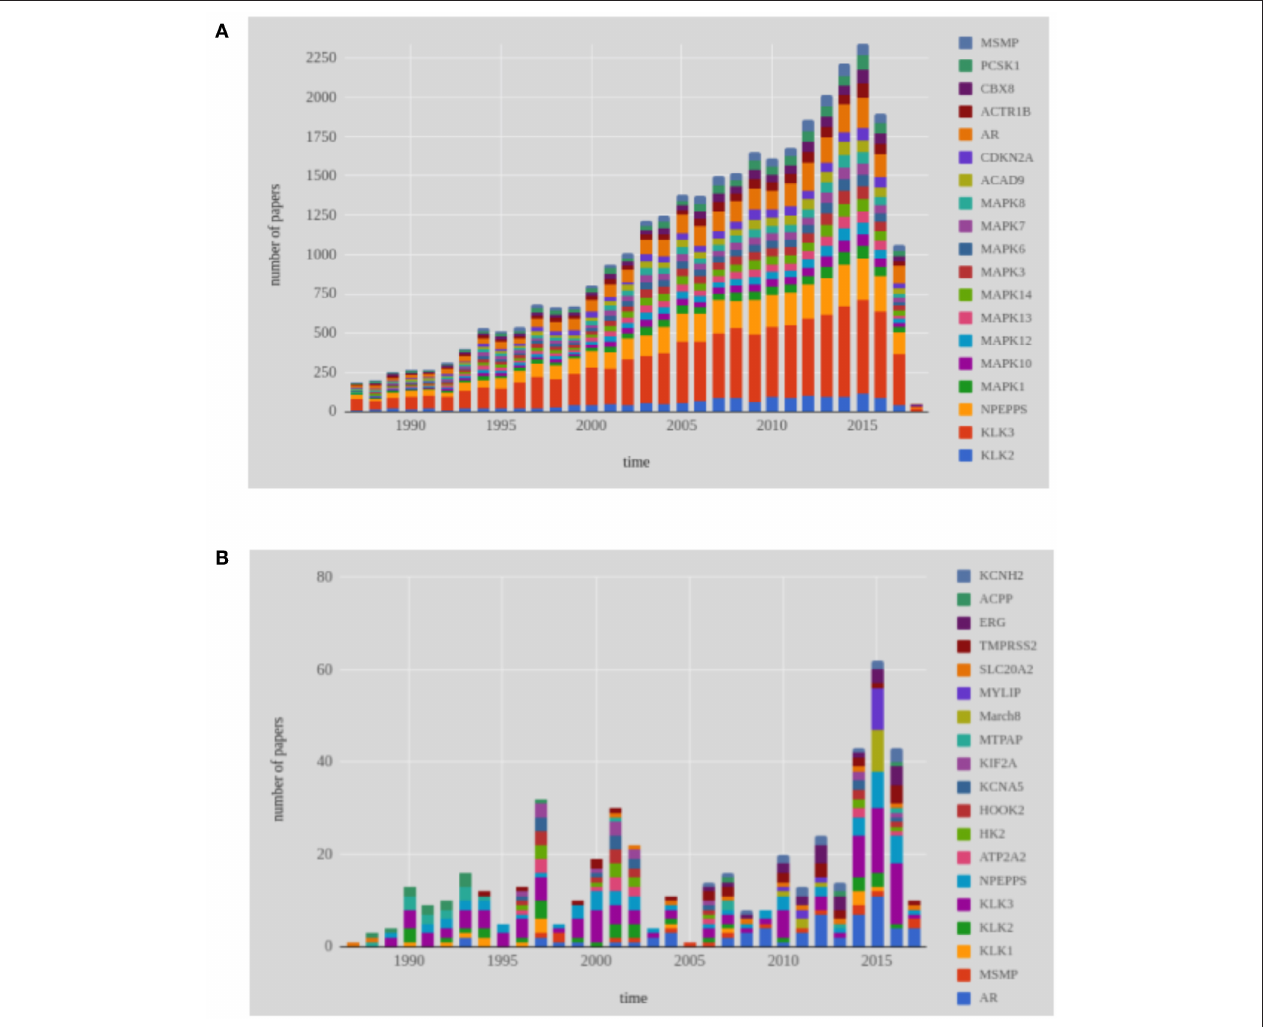
FIGURE 7 | Shown are results for the 19 most frequently studied genes in prostate cancer research from 1987 to 2017. (A) Genes studied worldwide, (B) Genes studied in